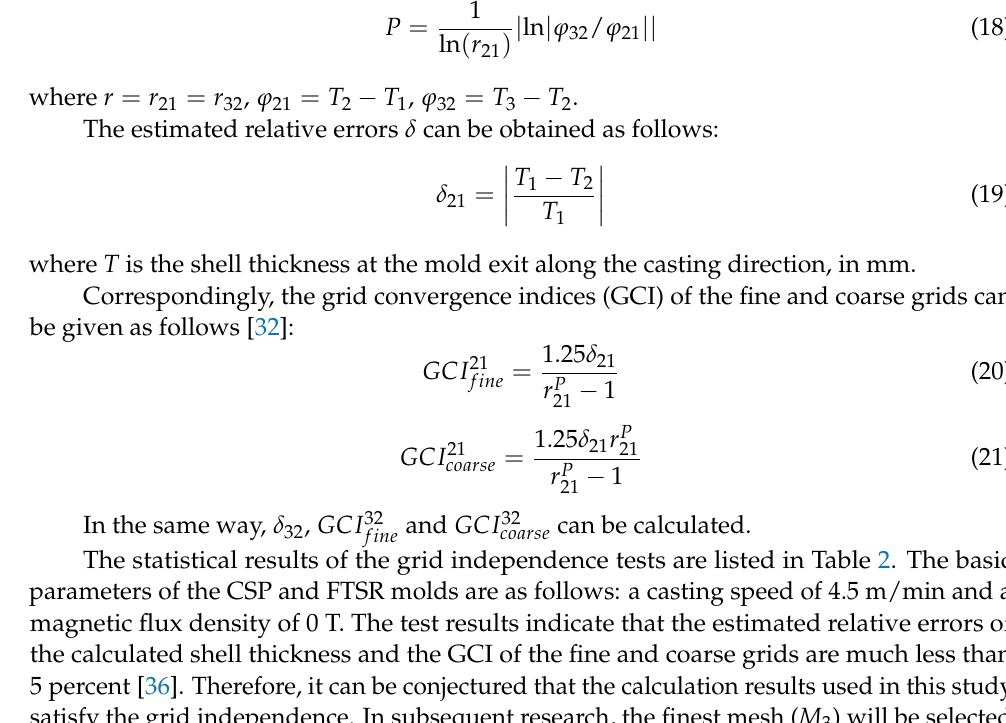
Figure 7. Schematic distribution of shell surface velocity on the funnel region of the FTSR mold: ( a ) X -velocity and ( b ) Y -velocity.